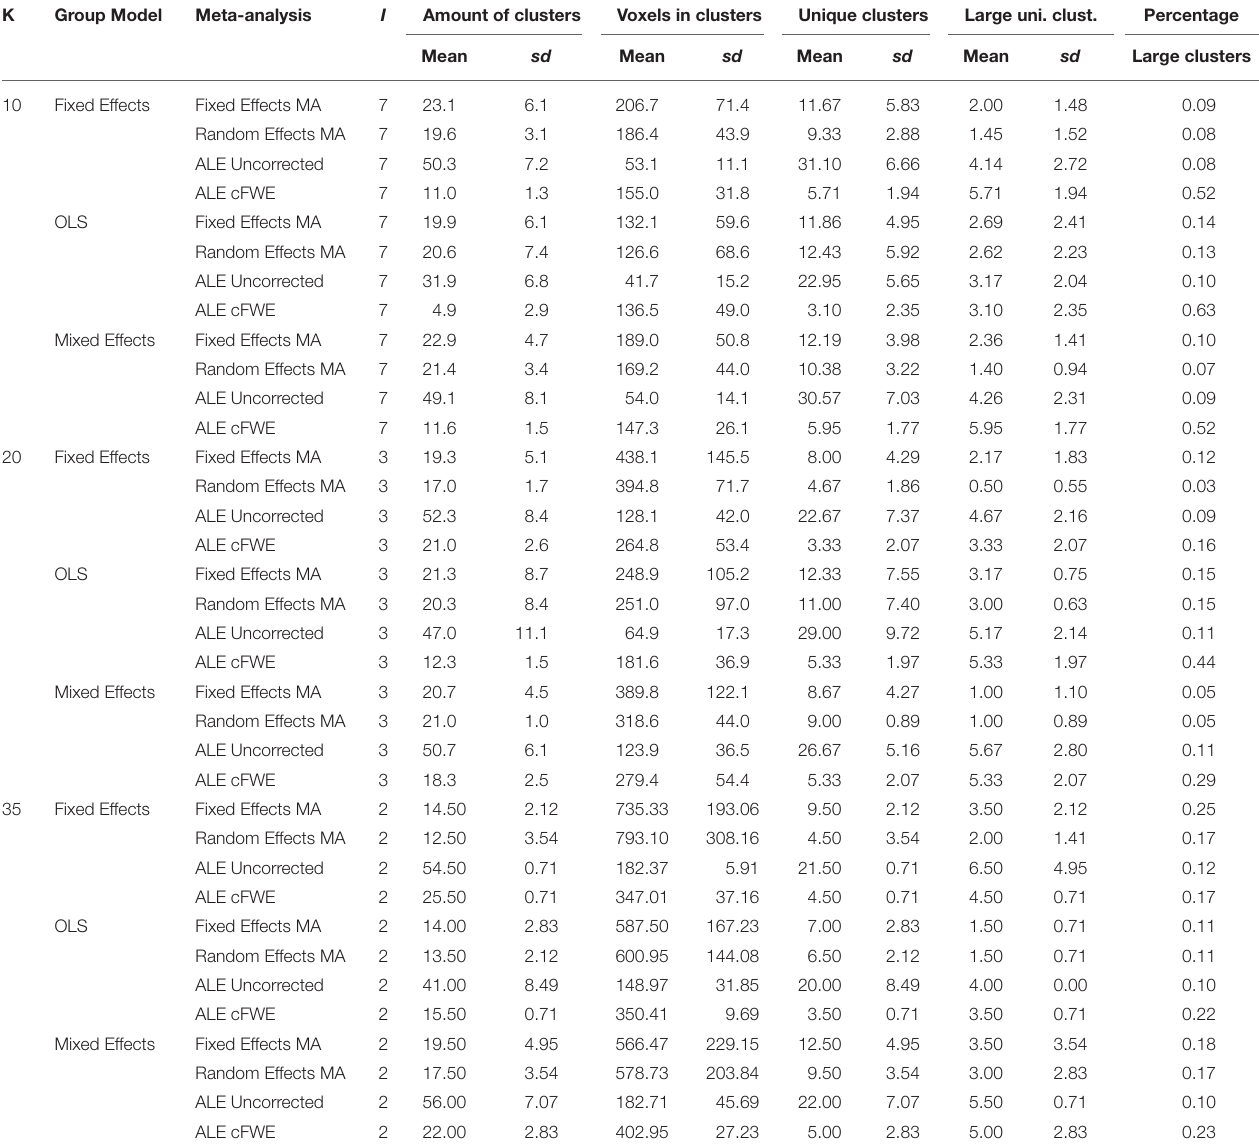
TABLE 3 | Descriptive results of the thresholded meta-analyses in a replication setting. K Group Model Voxels in clusters Unique clusters Large uni.